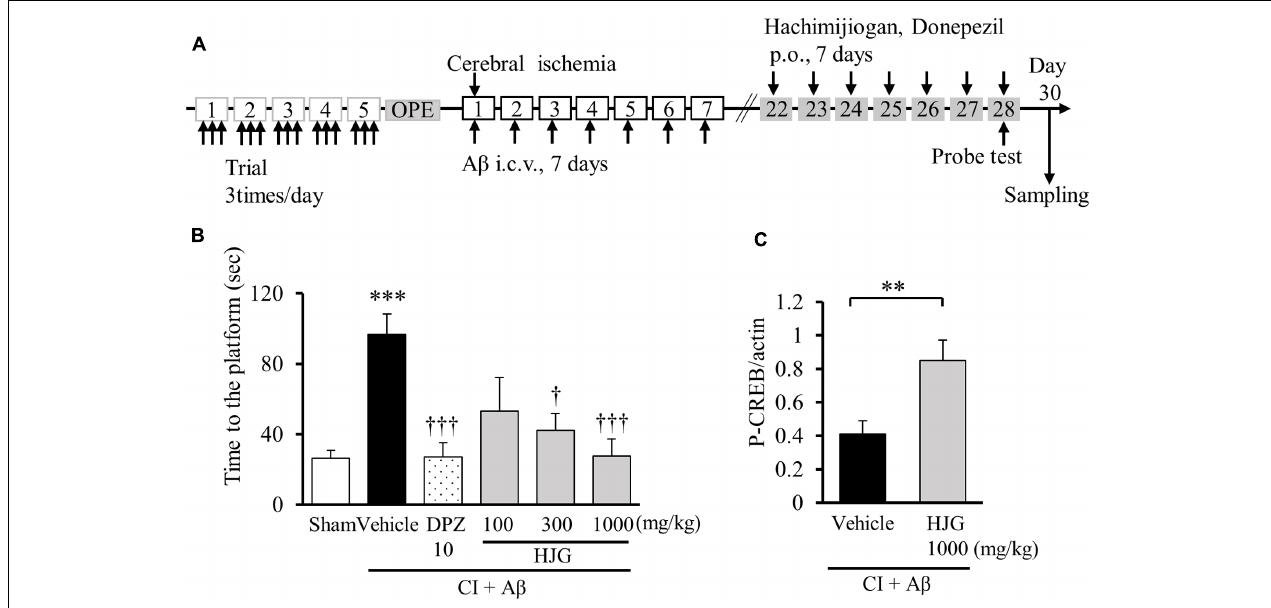
FIGURE 5 | Effect of HJG on memory impairment in rats treated with CI and A β protein (CI + A β ). (A) Schedule of experiment. Each rat underwent three trials daily for 5 consecutive days for memory acquisition. CI + A β rats were prepared by a combining intracerebroventricular A β injection with transient CI. On days 22–28 after CI, HJG, DPZ, or vehicle (water) was administered daily for 7 days. On day 28, cognitive function was analyzed with the probe test. On day 30, samples were collected from rat brains for Western blotting. (B) Swimming time to first reach the platform position. The probe test was performed 1 h after the 7th HJG treatment. Rats were allowed to swim freely for 180 s. Data represent mean ± SEM. ∗∗∗ p < 0.001 represents significant differences compared with Sham (Student’s t -test). † p < 0.05 and ††† p < 0.001 indicate significant differences between Vehicle (one-way ANOVA followed by Dunnett’s test). (C) HJG induces CREB phosphorylation in the hippocampus of CI + A β rats. Data represent mean ± SEM. ∗∗ p < 0.01 indicates significant differences compared with vehicle (Student’s t